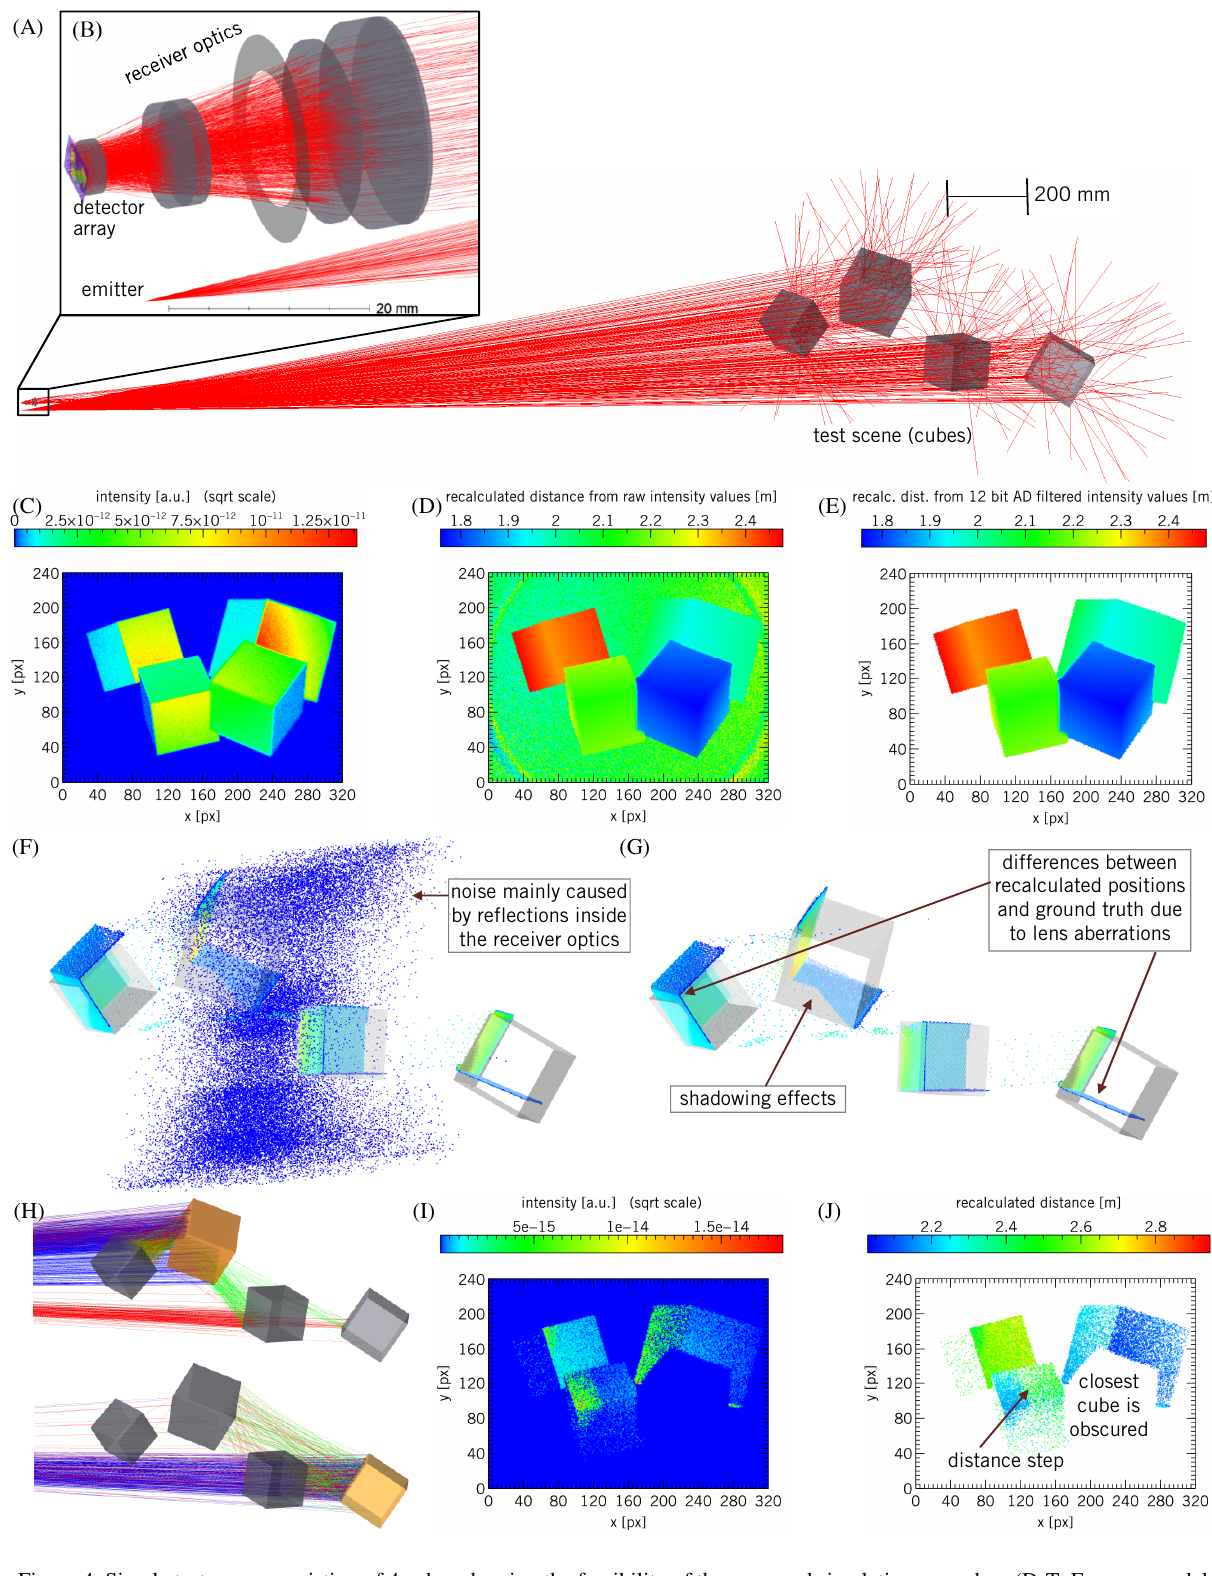
Figure 4. Simple test scene consisting of 4 cubes showing the feasibility of the proposed simulation procedure (D-ToF sensor model used). (A) Complete 3D scenery with ToF camera and cube objects. (B) Implementing the optically relevant ToF camera components comprising light source, receiver optics and detector array. (C) Intensity distribution of the received light. (D – E) Calculated depth from the optical path length using the global magnification factor correspondence (raw signal and 12 bit AD filtered). (F – G) 3D plot of the ground truth object positions overlaid with ToF sensor signals (raw signal and 12bit AD filtered). (H – J) Multiple cubes ray paths. (H) Two exemplary multiple cubes ray paths for rays first hitting the highlighted cube. (I) Intensity distribution of the ray paths which interacted with multiple cubes. (J) Calculated depth contribution from the multiple cubes ray